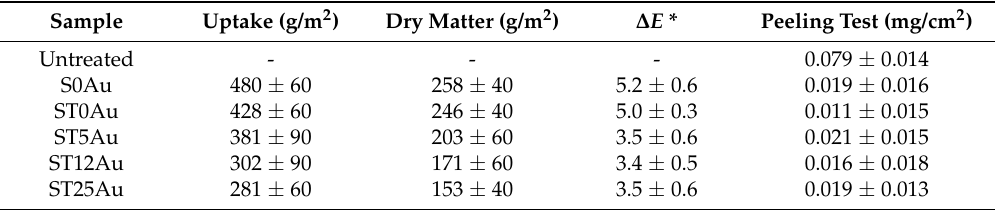
Table 3. Averages values and standard deviations for properties of treated stones.